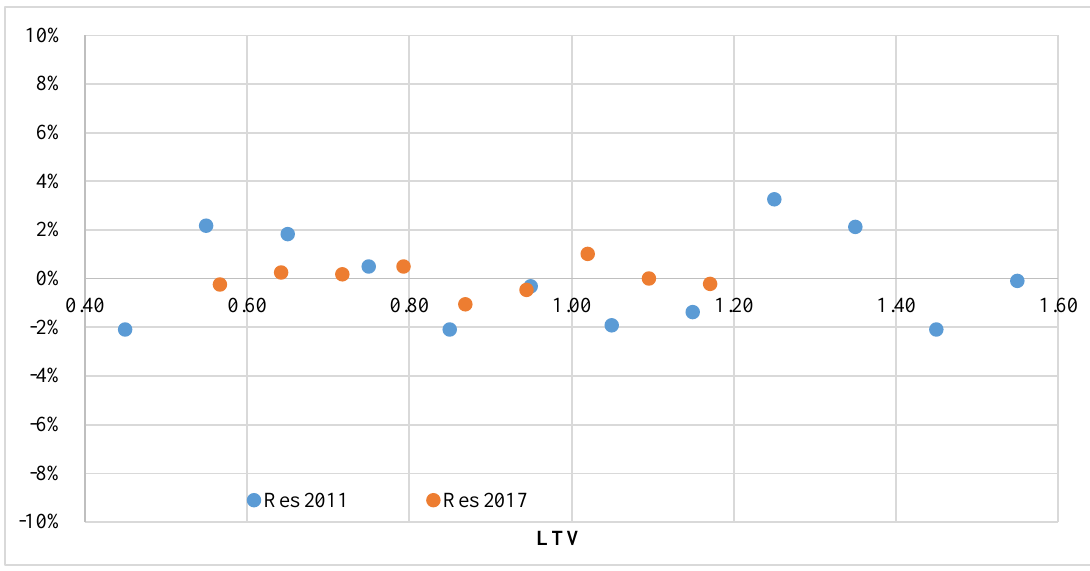
Figure 9. Residuals distributions for models with